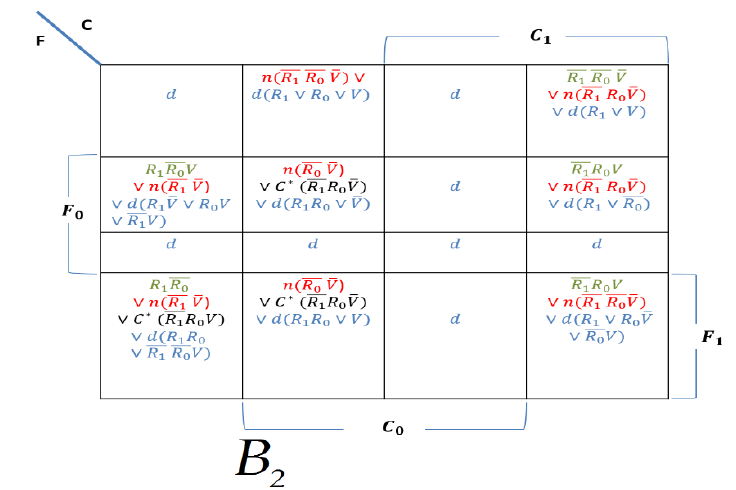
Fig. 9. A variable-entered-Karnaugh-Map representation of B 2 (party bans implementation), a